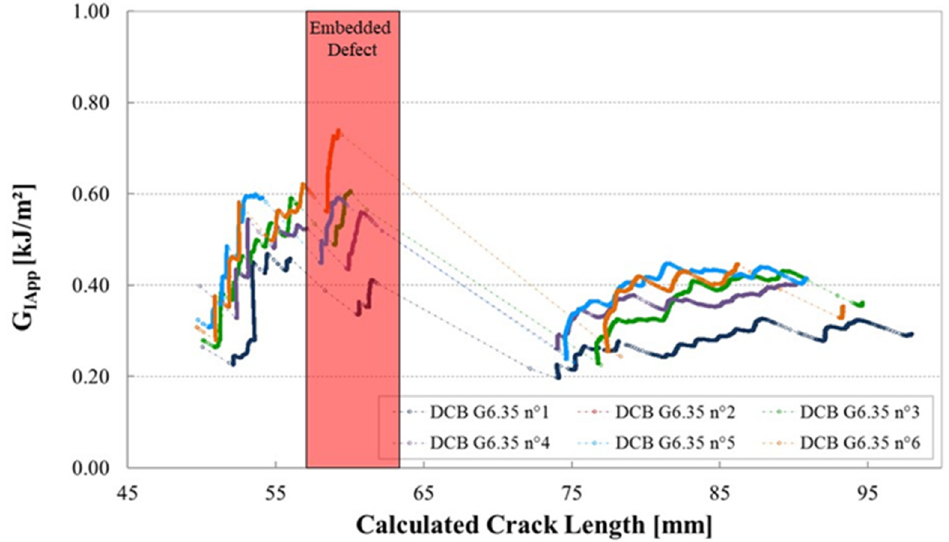
Figure 9. Mode I fracture R-curve, strain energy release rate versus the calculated crack length, for 6 DCB specimens containing a gap of 6.35 mm, manufactured with caul plate (calculated from plots in Figure 8).